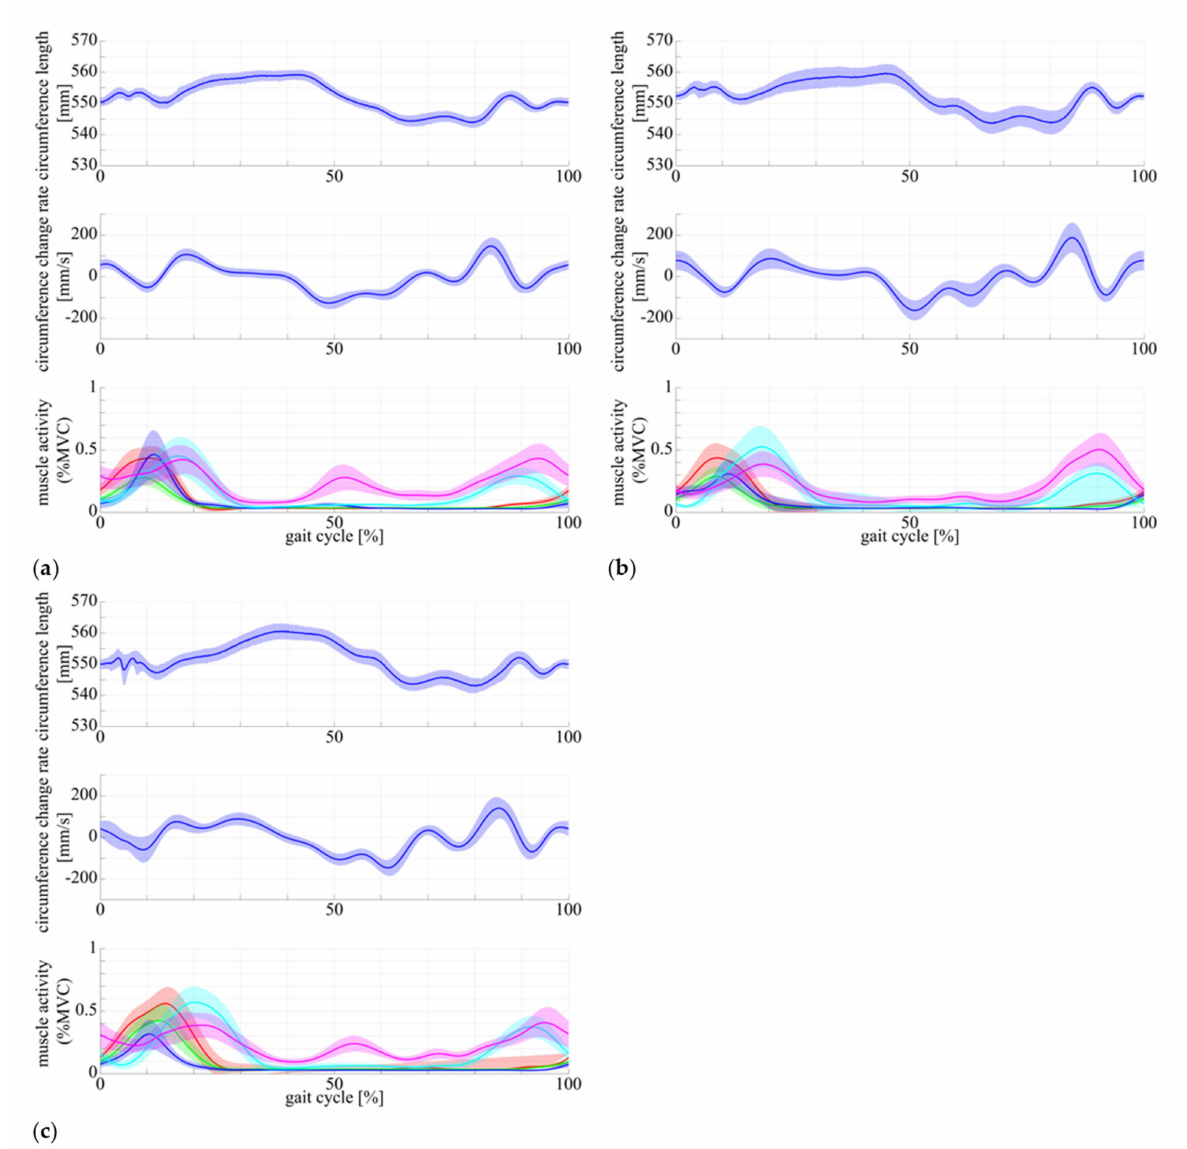
Figure 7. Stretch length, velocity, and muscle activity of running with ( a ) conscious muscle co-contraction, ( b ) neutral, and ( c ) conscious muscle relaxation. The horizontal axis represents the gait cycle (%), and the vertical axis represents the stretch length (mm) in top, stretch velocity (mm/s) in middle, and muscle activity normalized by MVC in bottom. Each color of line represents same item as the one in Figure